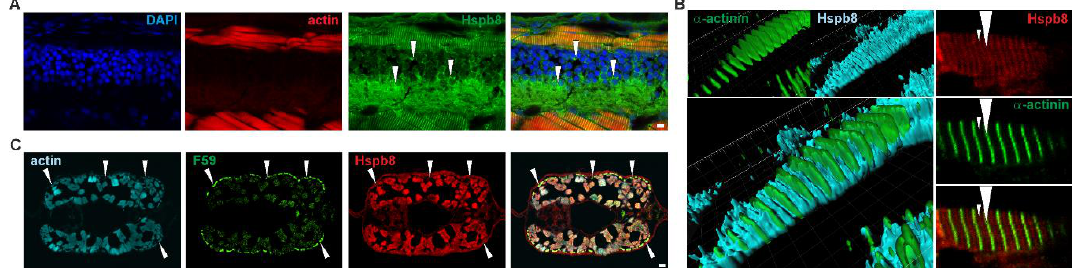
Figure 2. Tissue-specific and subcellular localization of Hspb8 during zebrafish development. ( A ) Hspb8 (green) subcellular distribution in the cytoplasm of neurons (white arrowhead) in the lateral spinal cord. Actin detected with Fluor 546-conjugated phalloidin (red). DNA was stained with DAPI (blue) in the lateral sections of the mid-trunk region of 72 hpf zebrafish embryos. Scale bar: 5 μm. ( B ) Hspb8 subcellular distribution in muscle fiber of 120 hpf zebrafish larvae. Left: 3D reconstruction (Imaris) of Hspb8 (light blue) and α-actinin (green, a marker of Z-line). Right: Localization of Hspb8 (red) and α-actinin (green) in muscle fiber of 120 hpf zebrafish larvae. Small arrowhead indicates M-line, large arrowhead indicates Z-line. Images were obtained with a confocal laser scanning microscope (Olympus FV1000). Cryosection (14 μm thick). Images represent the single Z-section (0.45 μm thick). ( C ) Hspb8 (red) is present in both white and slow muscles (white arrowhead). The slow muscle was detected using the F59 antibody (green) and actin with Fluor 546-conjugated phalloidin (light blue) in the cross-sections of the mid-trunk region of 120 hpf zebrafish embryo. Scale bar: 10 μm.